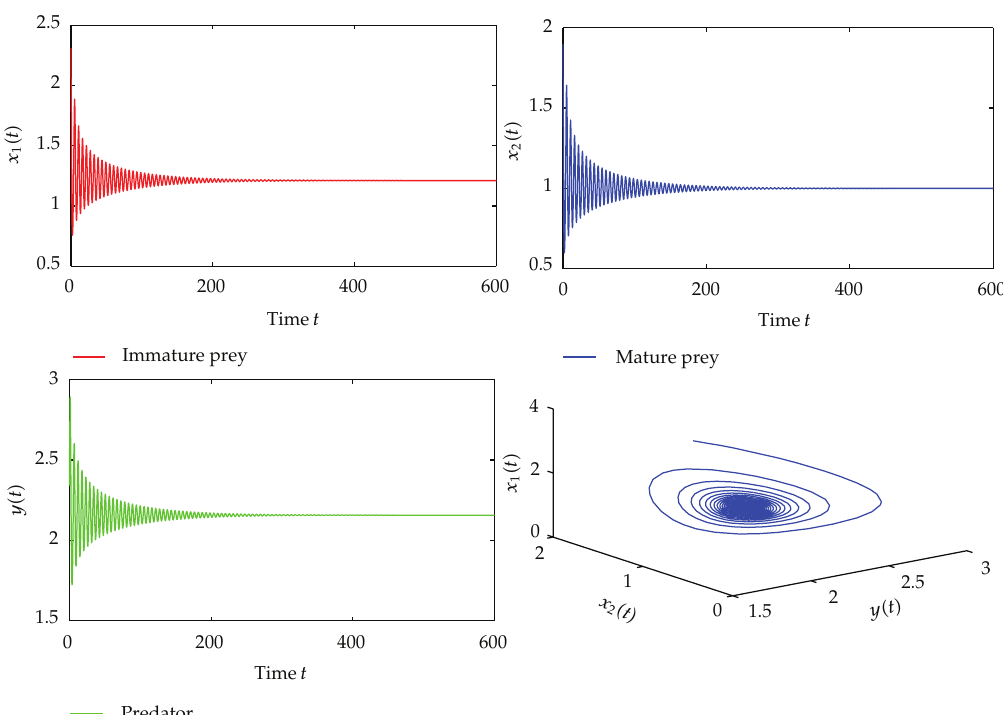
(cid:6) 0 . 6125 and τ (cid:7) (cid:6) 0 . 25 with initial value 2 ∗ 1 ∗